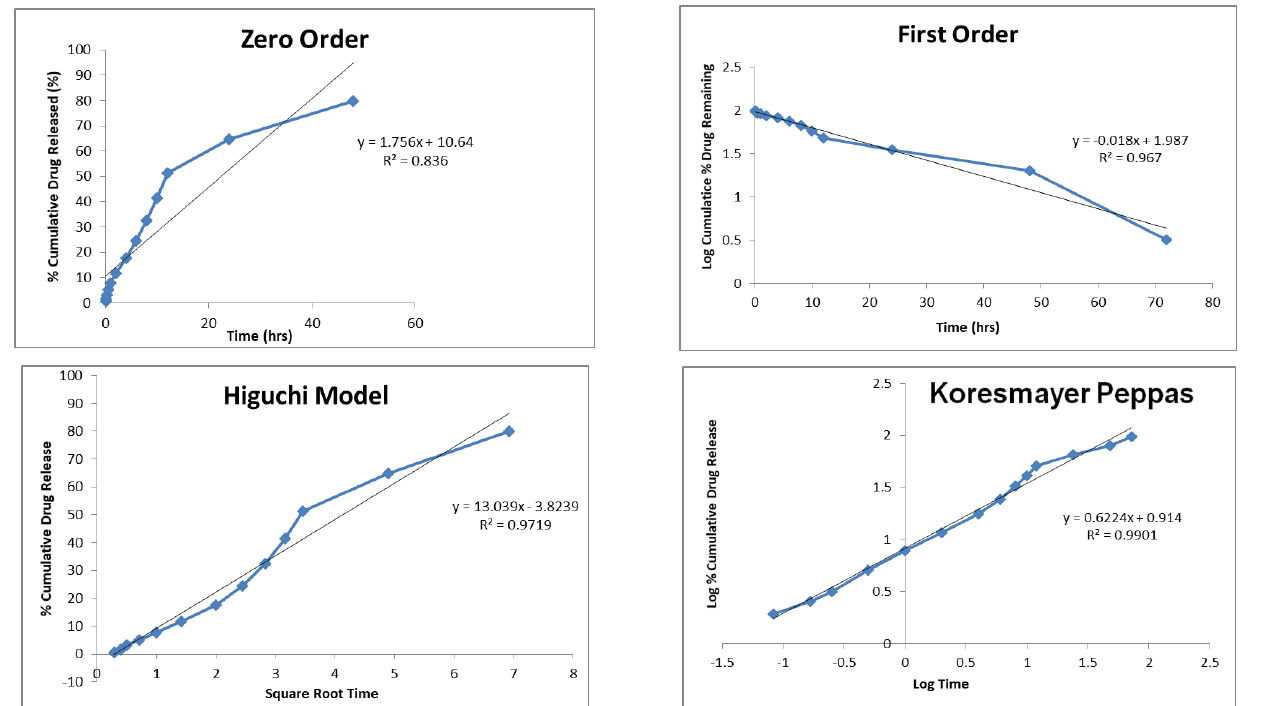
Figure 8. Graphical representation of kinetic-data analysis of methotrexate-loaded